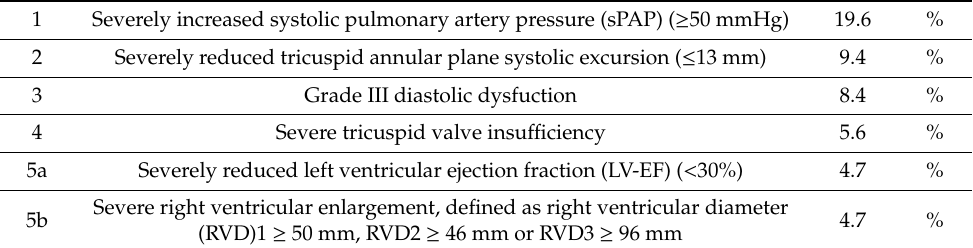
Table 3. The five most frequently observed critical cardiac